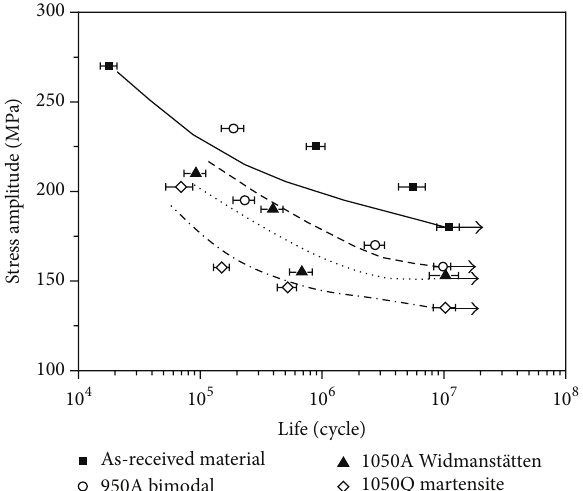
Figure 9: Stress amplitude versus life curves of AR material, martensite, Widmanst¨atten, and bimodal microstructures of Ti6Al4V.